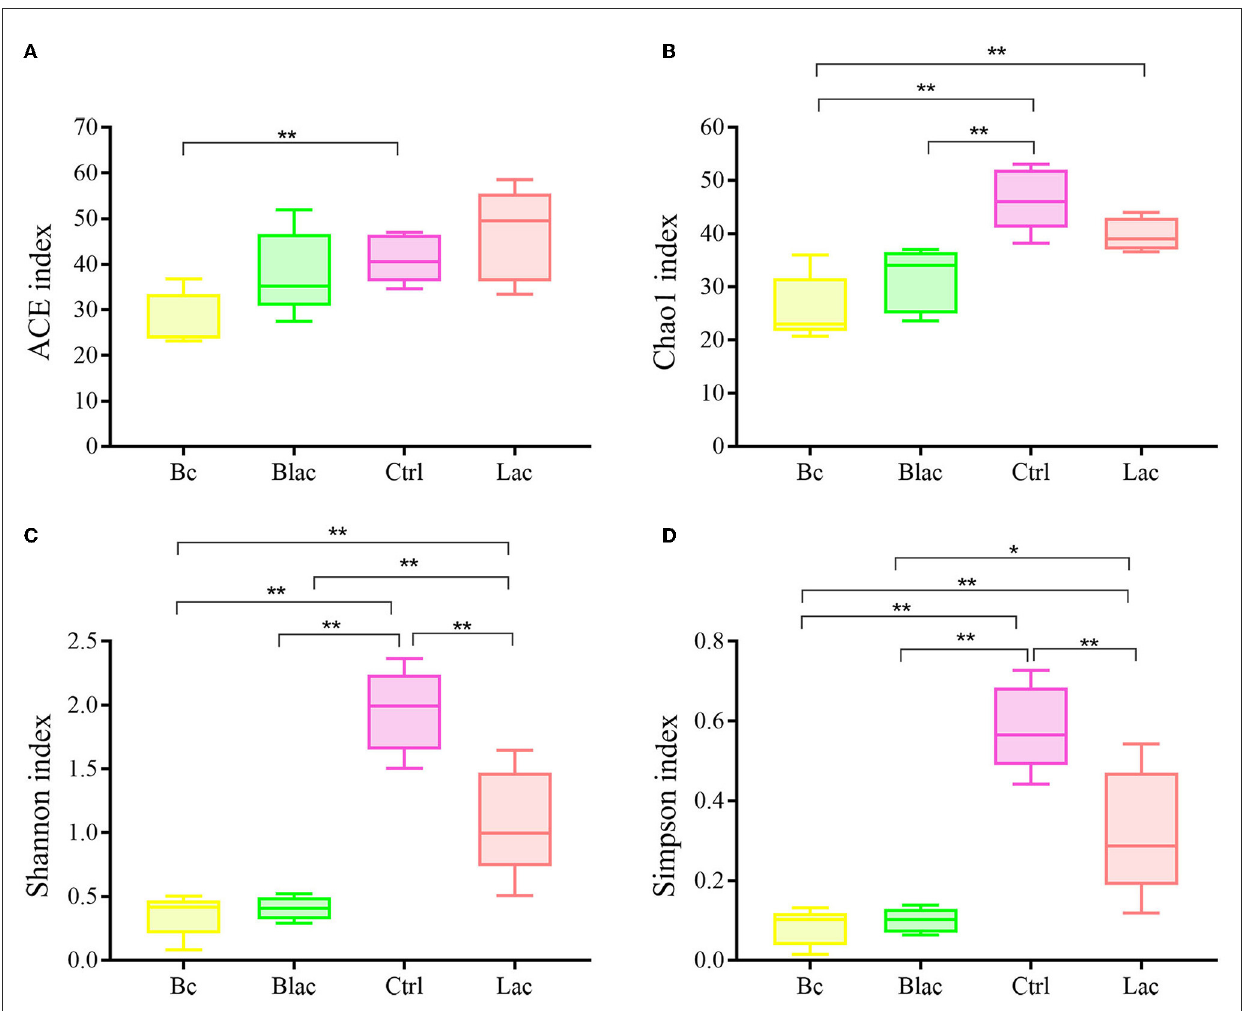
FIGURE4 Alpha diversity indices [ (A) Shannon index, (B) Ace index, (C) Chao1 index, and (D) Simpson index]; Bc, added with strain B. cereus AH7-7; Blac, added with strain B. cereus AH7-7, Lactobacillus plantarum and Lactobacillus buchneri ; Lac, added with Lactobacillus plantarum and Lactobacillus buchneri ; Ctrl, no additives. *means significant difference ( P < 0.05); **means extremely significant difference ( P <